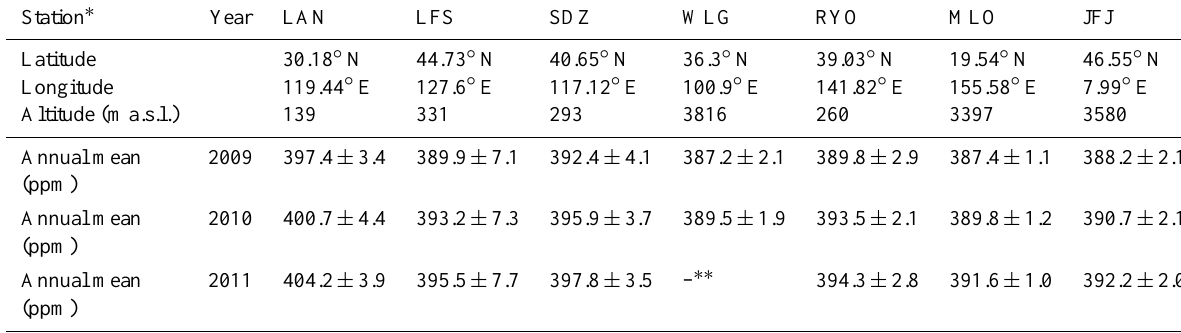
Table 3. Comparison of yearly CO 2 mole fractions with other WMO/GAW